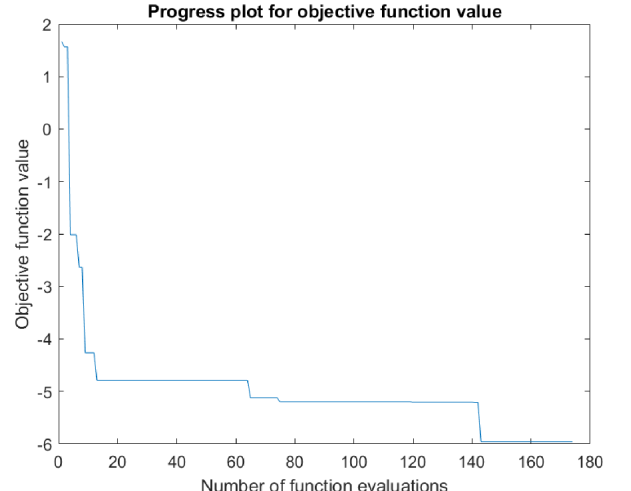
Figure 5. Power and load objective function weights as a function of load increase. Figure 6. Progress plot of the objective function value.